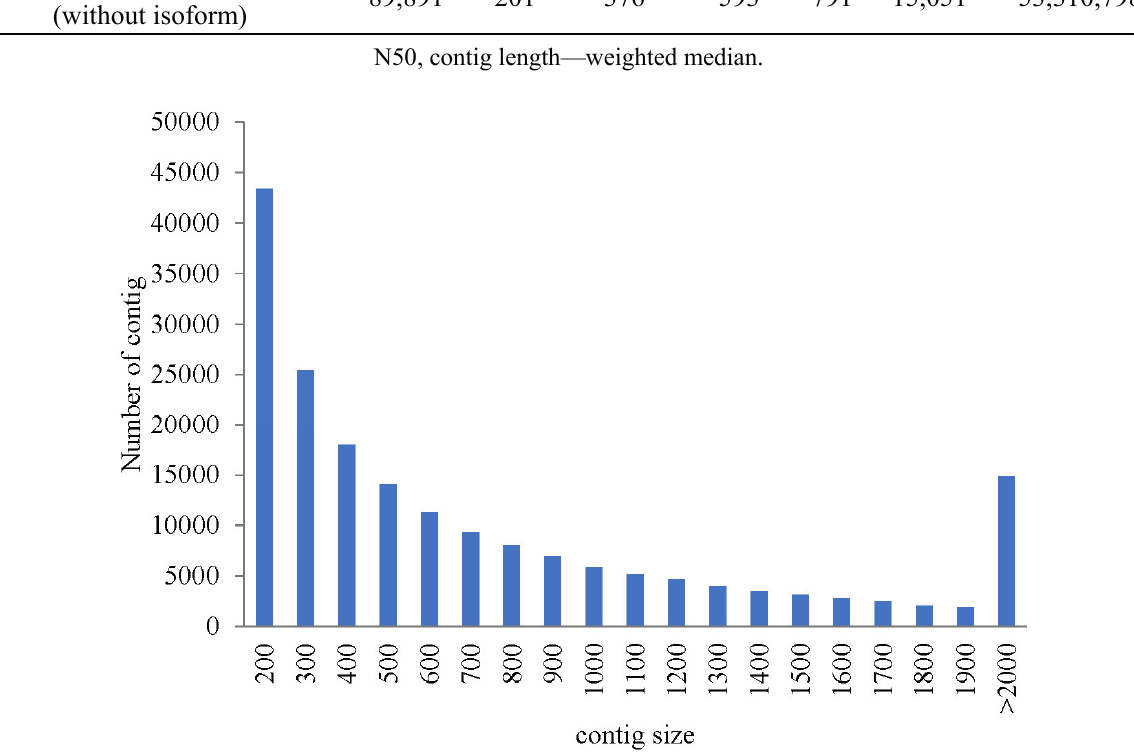
Figure 1. The length distribution of assembled contigs in the sequenced cDNA